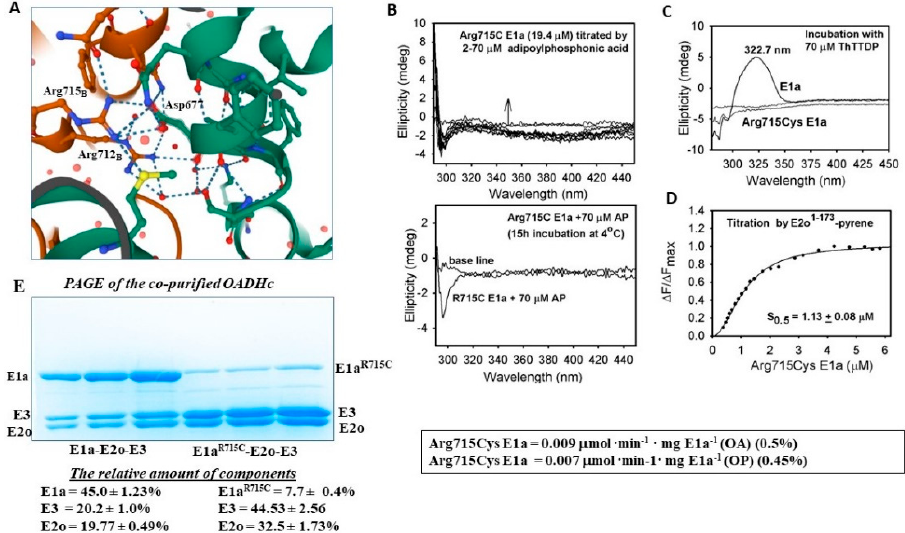
Figure 6. The multipronged analyses of the Arg715Cys E1a variant. ( A ) Scheme showing hydrogen bond formation in E1a between the Arg715, Arg712 in subunit B and Asp677 in subunit A. Image was created by using Mol* Viewer [34] and accession PDB ID: 6sy1 in RCSB PDB. ( B ) Circular dichroism titration of Arg715Cys E1a by adipoylphosphonic acid. ( C ) Circular dichroism titration of E1a and Arg715Cys E1a by thiamine thiothiazolone diphosphate (ThTTDP), an analogue of ThDP. ( D ) Fluorescence titration of the E2o 1-173 di-domain comprising the lipoyl domain, subunit binding domain and part of the core domain by Arg715Cys E1a. ( E ) The relative amount of the individual components assembled into OADHc by co-purification estimated based on the intensity of the individual bands in the SDSPAGE. See Section 3 for experimental